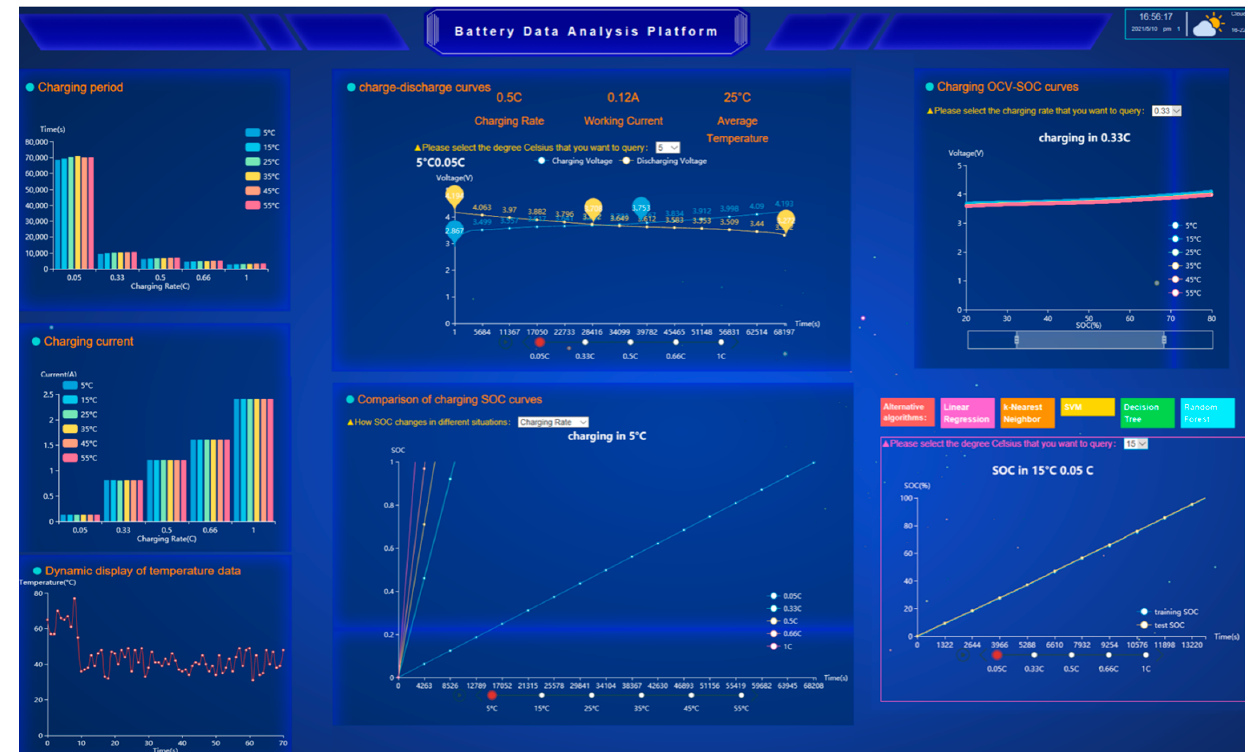
Figure 10. Overview of data analysis web platform for power battery.